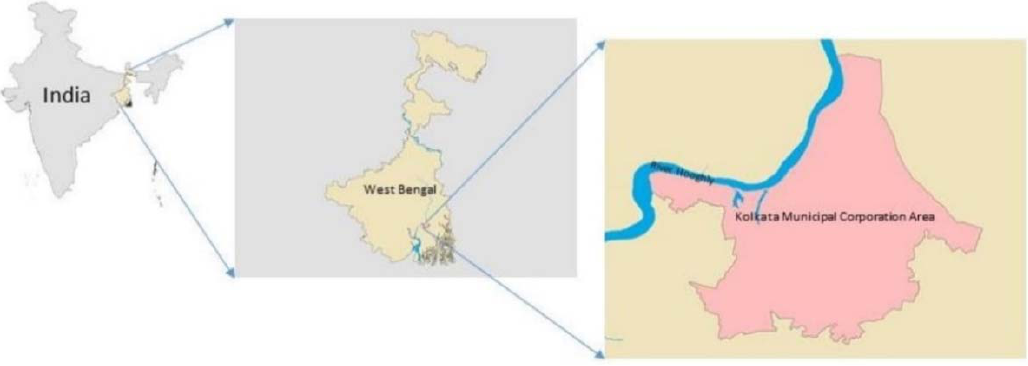
Figure 1. Location of Kolkata Municipal Corporation area (Source: Kolkata Municipal Corporation, 2016).